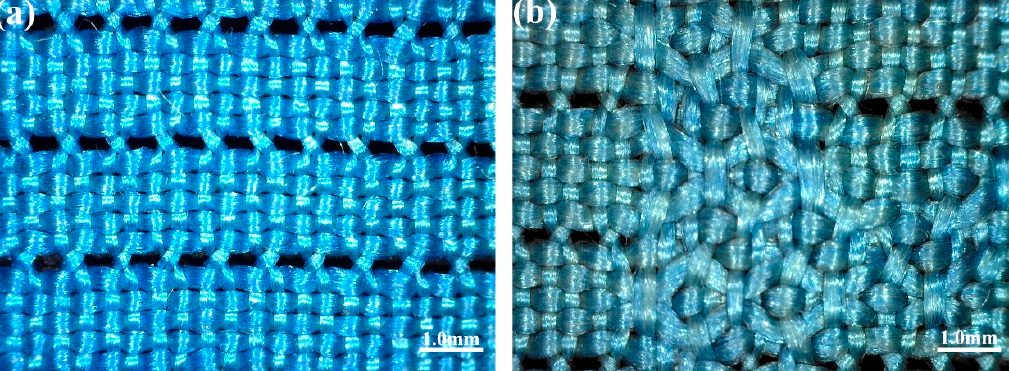
Figure 2. The observation of the plain weave structure of the marquisette curtain ( a ) ×50; ( b ) ×50.